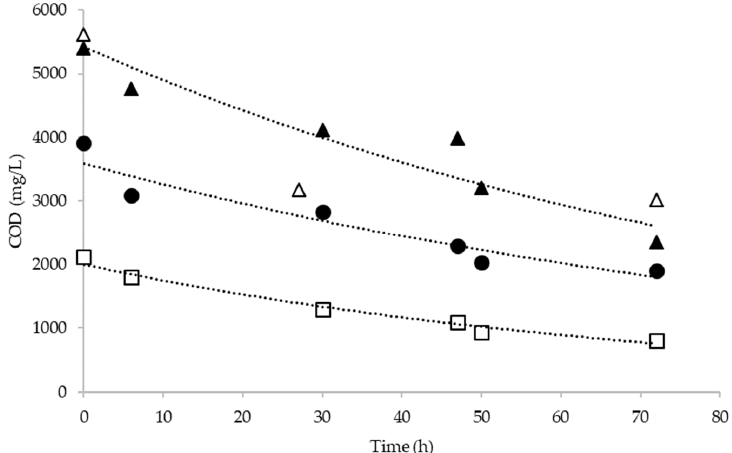
Figure 8. COD vs. time and first order kinetics at different initial concentration (TOC initial concentration: ( ○ ) 800 mg/L, ( ● ) 1400 mg/L, ( ▲ ) 2000 mg/L and ( □ ) 2800 mg/L).